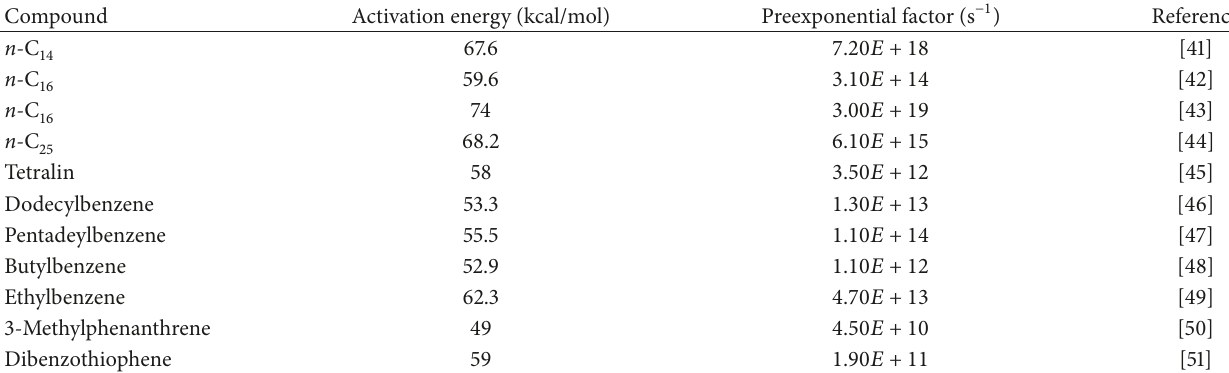
Table 3: Kinetics parameters for the cracking of individual organic compounds.